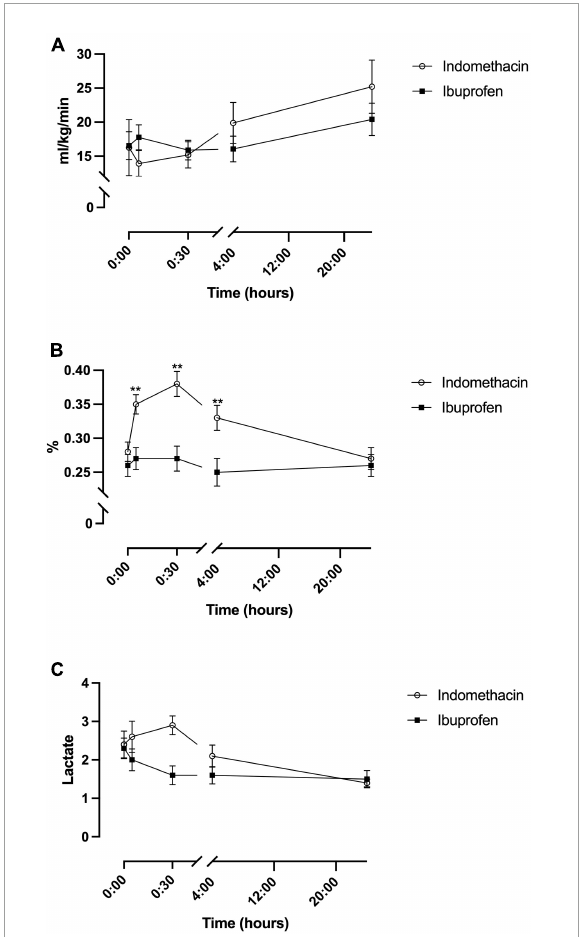
FIGURE3 Temporal changes in oxygen consumption for the indomethacin and ibuprofen treatment groups. (A) modCerbVO 2 . (B) Cerebral fractional oxygen extraction. (C) Arterial lactate. ** p < 0.01 between treatment group difference at that study